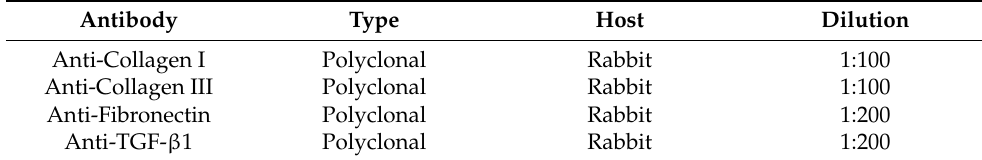
Table 4. List of antibodies used in the